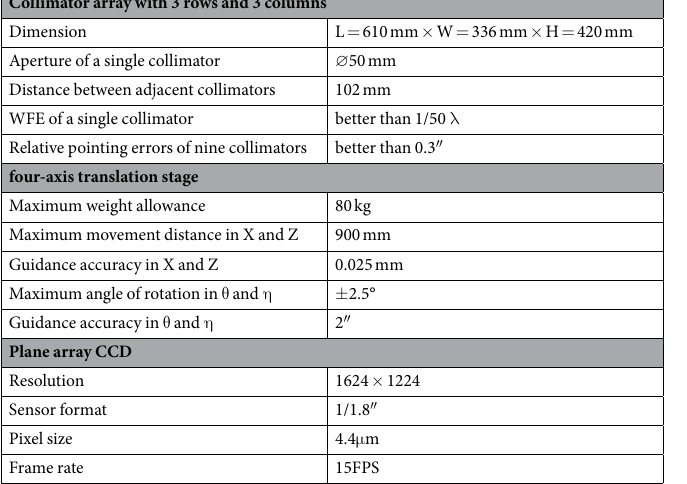
Collimator array with 3 rows and 3 columns